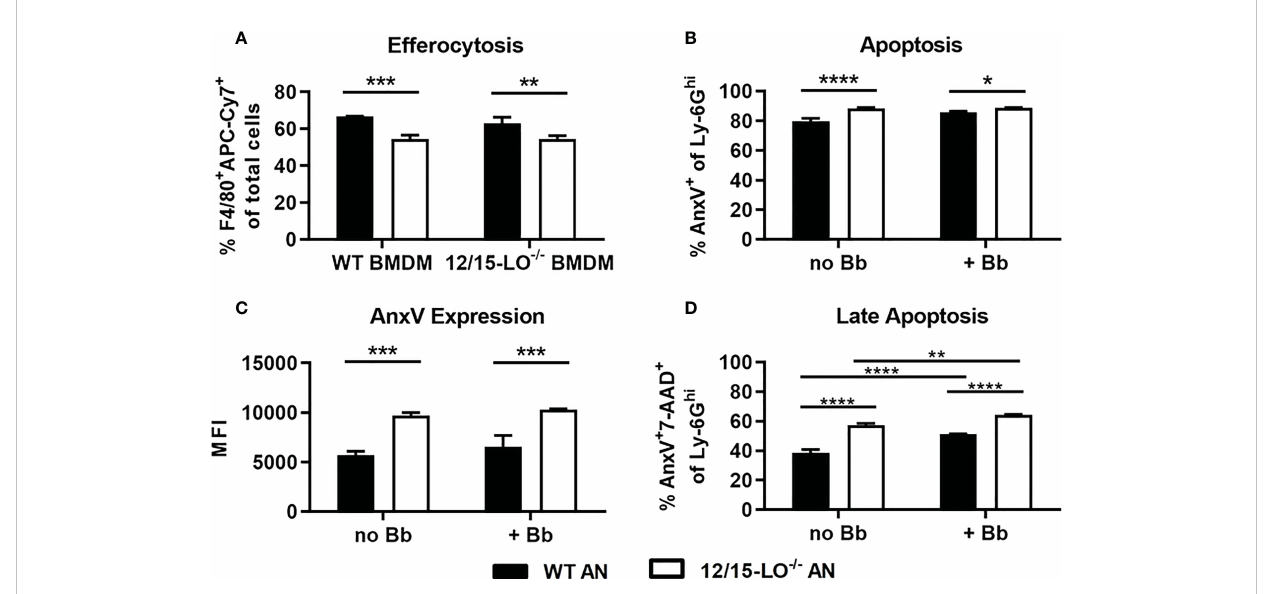
FIGURE 4 Apoptosis and efferocytosis in 12/15-LO -/- bone marrow neutrophils and macrophages. Bone marrow neutrophils (BMN) were isolated and cultured for 24hr to induce apoptosis. (A) Untreated APC-Cy7-stained apoptotic BMN (AN), either WT (black bars) or 12/15-LO -/- (white bars), were cultured with WT or 12/15-LO -/- BMDM (2:1) for 4hr, and efferocytosis, de fi ned as F4/80 + APC-Cy7 + cells, was determined by fl ow cytometry. Apoptosis of WT and 12/15-LO -/- in 24hr culture +/- Bb (MOI 10) was measured by proportion (B) and MFI (C) of AnxV expression. (D) Late-stage apoptosis in cultures from B&C as measured by AnxV and 7-AAD co-staining. n=3/group, assayed in duplicate. (A – C) *p<0.05, **p<0.01, ***p<0.001, ****p<0.0001 by t-test, (D) one-way ANOVA with Tukey ’ s